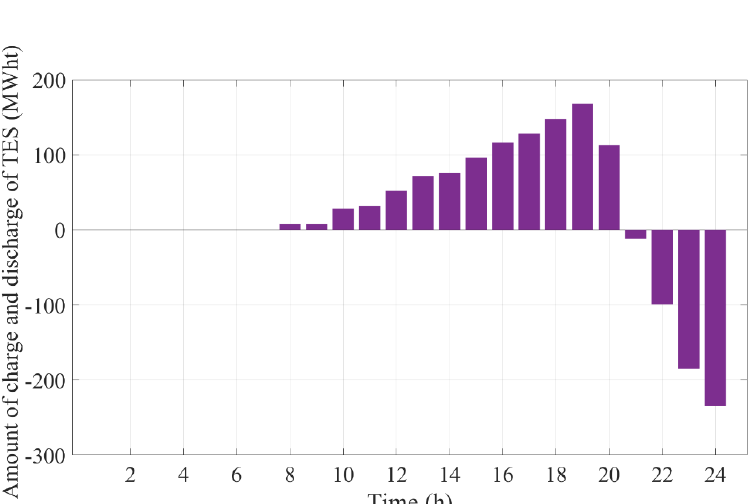
Figure 12. Amounts of charge and discharge of TES in the CSP plant associated with case 3.